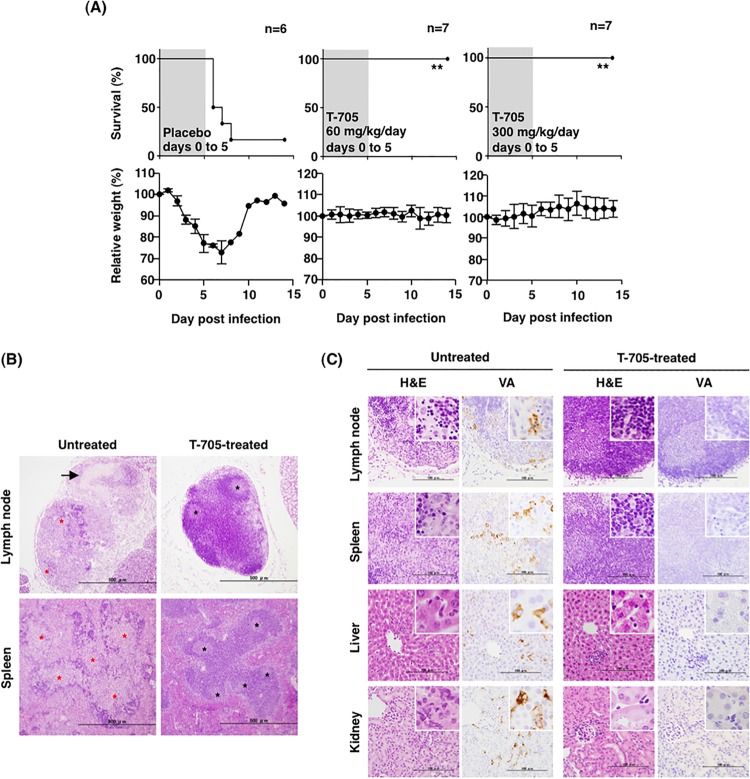
T-705 treatment of SFTSV-infected IFNAR−/− mice through oral administration. (A) Six or seven female mice in each group were inoculated s.c. with 1.0 × 106 TCID50 of SFTSV (SPL010). Mice were treated with T-705 at a dose of 60 or 300 mg/kg/day. The drug was administered once daily p.o. using a stomach probe. Placebo mice received 2.9% sodium bicarbonate solution as a solvent for T-705. T-705 was administered for 5 days as indicated in the upper columns (shaded in gray with the survival curves). Survival was determined using Kaplan-Meier analysis and GraphPad Prism6. **, P < 0.01 compared with the results of the placebo group. Relative weight is shown as means with standard deviations. (B and C) Histopathological and immunohistochemical examinations of the tissues collected from the SFTSV-infected IFNAR−/− mice treated with T-705 or left untreated. Tissues were collected from mice at 4 days postinfection (untreated mice) or at 12 days postinfection (T-705-treated mice). (B) Low-power views of the cervical lymph node and the spleen. Bars, 500 µm. The arrow (upper left) indicates necrosis; blask asterisks indicate intact structures; red asterisks indicate necrosis. (C) Histopathology and immunohistochemical analyses of cervical lymph nodes, spleens, livers, and kidneys. Bars, 100 µm. H&E, hematoxylin-and-eosin staining; VA, viral antigens detected by immunohistochemistry.